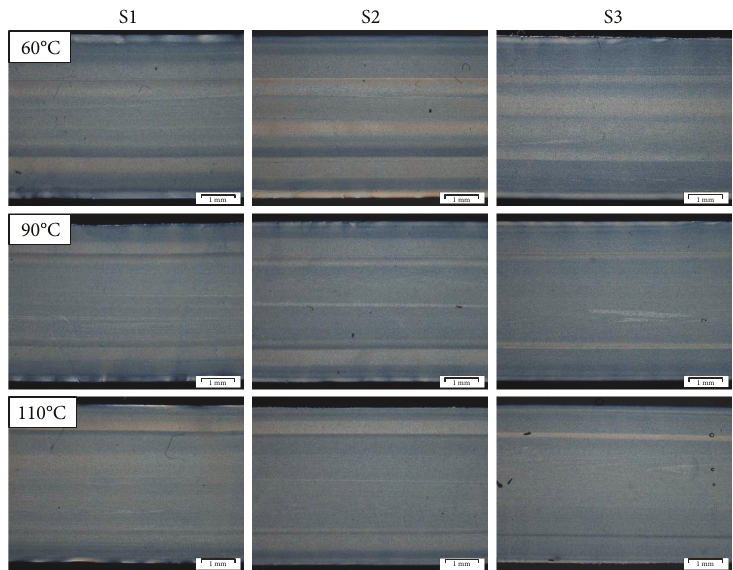
Figure 8: PLM images of the cross section of injection-molded Delrin plates in dependence on the distance from the sprue and on the mold temperature used.